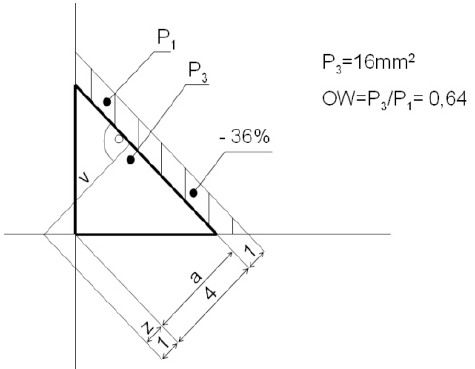
Fig. 2b. Fillet-penetrated weld